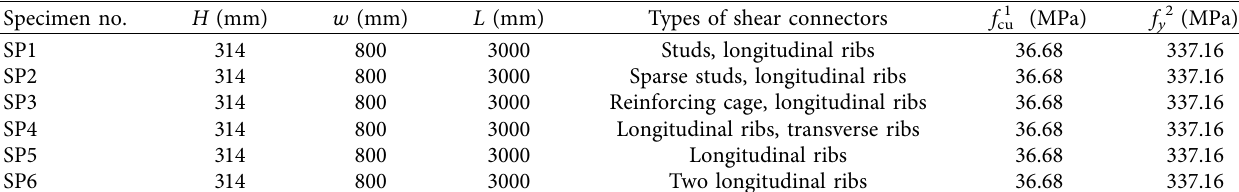
Table 4: Details of the